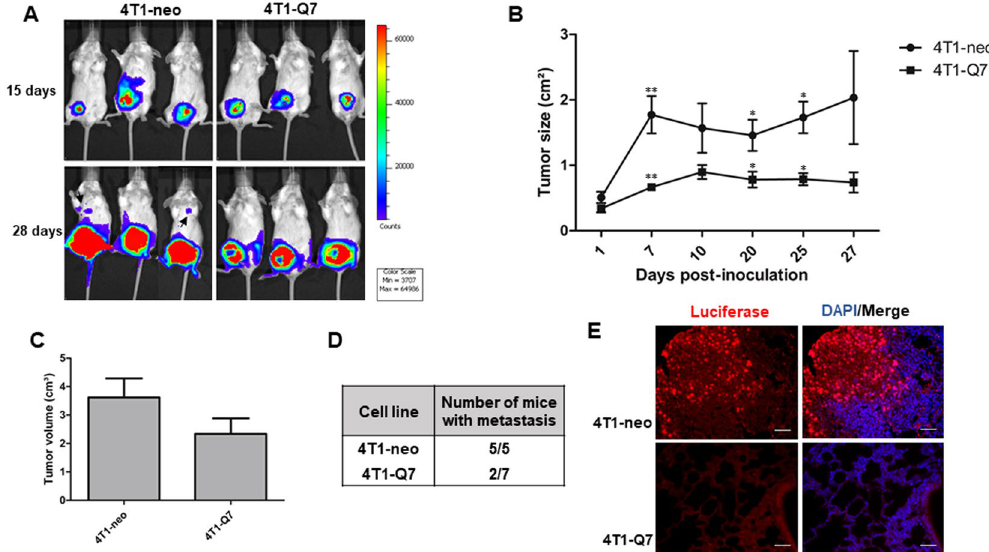
Figure 8. Overexpression of Q7 reduces tumor growth and metastatic potential of 4T1 cells. ( A ) Representative whole body bioluminescence images of mice with tumors induced by the indicated cell lines at 15 and 28 days post-injection. Note that 4T1-neo, but not 4T1-Q7 mice show metastatic colonies at 28 days (arrows). ( B ) Tumor growth was monitored at different post-injection days by measuring the bioluminescence area as indicated in Materials and methods. Asterisks indicates statistically significant differences ( * p < 0.05; ** p < 0.01). ( C ) Measurement of the volumes of primary tumors at 28 days post-inoculation. n.s., statistically non-significant. ( D ) Incidence of pulmonary metastases at 28 days post-inoculation. ( E ) Immunofluorescence detection of luciferase in lungs of mice with mammary tumors induced by 4T1-neo and 4T1-Q7 cells at 28 days post-injection. Nuclei were stained with DAPI. Bars, 100 μ